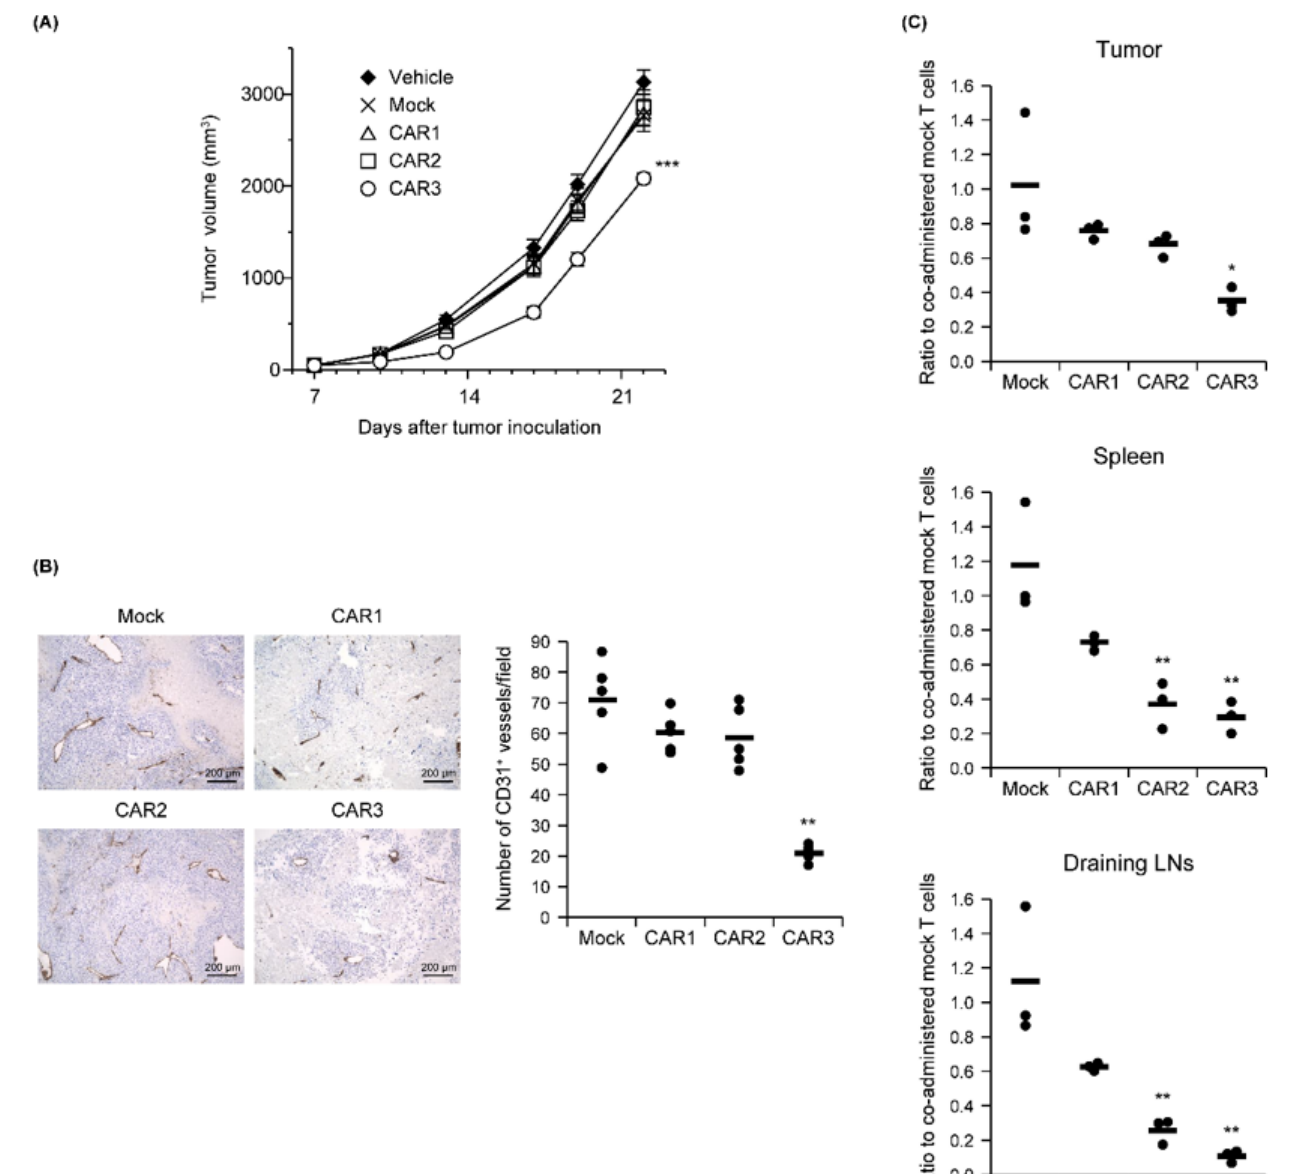
Figure 4. In vivo function of anti-Robo4 CARs. C57BL/6 mice bearing B16BL6 tumors were intrave- nously injected with anti-Robo4 CAR-T cells or control mock-T cells at 5 × 10 6 cells/mouse on day 7 after tumor inoculation. ( A ) Tumor volumes over time. Each point represents the mean ± SE from 10 mice. Statistical analysis was performed using two-way analysis of variance: *** p < 0.001 vs. mock control. ( B ) Left, expression of CD31 cells in tumor tissue. Bar, 200 µm. Right, CD31 expression quantified by counting 5 fields per specimen. The circle represents an individual and the bar indi- cates the mean. Data represent means ± SD. Statistical analysis was performed using Dunnett’s t - test: ** p < 0.01 vs. mock group. ( C ) CAR-T cell tissue accumulations detected by FCM. Cells were pregated live, Thy1.1 ⁺ , and CD8 α⁺ cells. Ratios to co-administered mock T cells were calculated CAR-T cell treatment (cells stained with Cell Proliferation Dye eFluor 670)/mock-T cell treatment (cells stained with Tag-it Violet Proliferation and Cell Tracking Dye). The circle represents an indi- vidual and the bar indicates the mean. Statistical analysis was performed using Dunnett’s t -test: * p < 0.05, ** p < 0.01 vs. mock.